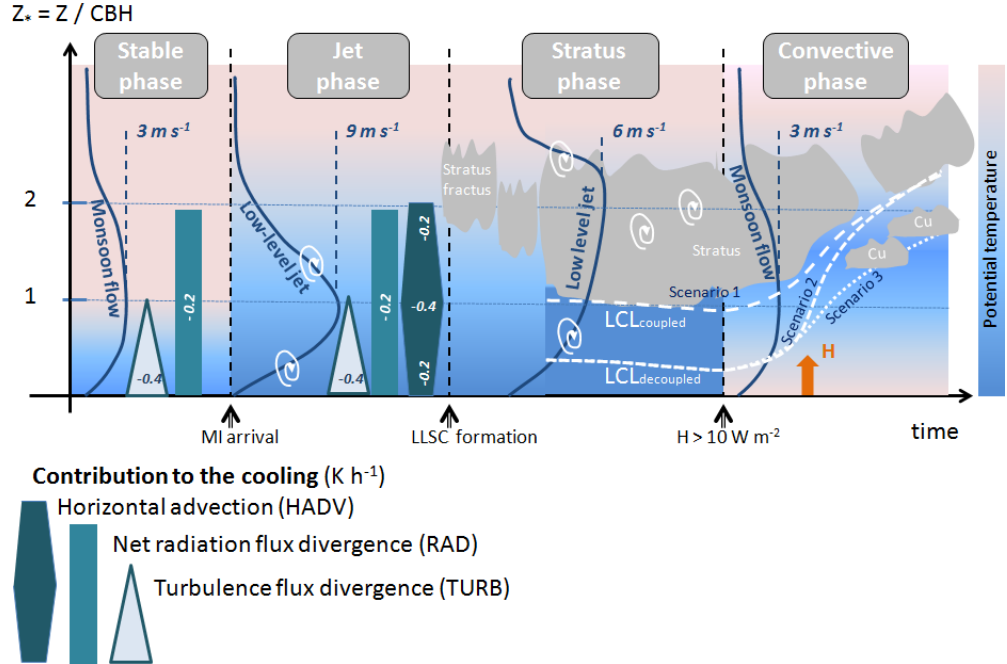
Figure 2. Conceptual model for the LLSC diurnal cycle over southern West Africa. The height is normalized by the LLSC base height when the stratus clouds form ( Z ∗ = Z/ CBH). The grey shades represent the LLSC (stratus fractus or stratus) or cumulus cloud (Cu). The three dashed white curves indicate the lifting condensation level (LCL). Each of them represents one scenario (of three) of CBL development found during the DACCIWA field campaign (Sect. 3.2.3). The dark blue lines reproduce the vertical profiles of the wind with an indication of its maximum value for each phase. The various blue symbols at the bottom represent the processes involved in the potential temperature tendency equation (The shape is adapted to the contribution of each term to the local total cooling, as a function of height.) (Sect. 3.1.2). H stands for the surface sensible heat flux and is symbolized by an orange arrow during the convective phase. The curled white arrows symbolize nocturnal dynamical turbulence either due to the radiative cooling at the cloud top or to the wind shear in the